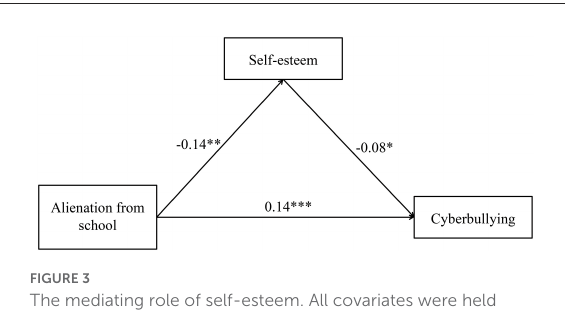
FIGURE3 The mediating role of self-esteem. All covariates were held constant during this analysis but are not presented for reasons of simplicity. *** p < 0.001, ** p < 0.01, * p <